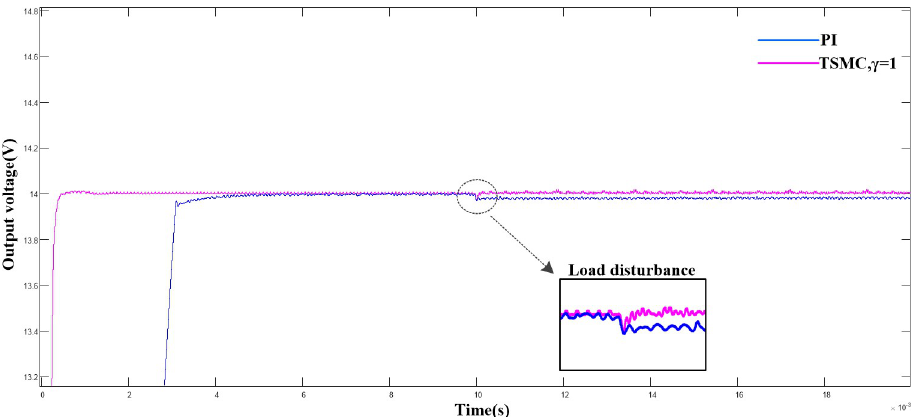
Fig 5. Comparison of output voltage waveform between double closed loop PI control and terminal sliding mode control under load disturbance.